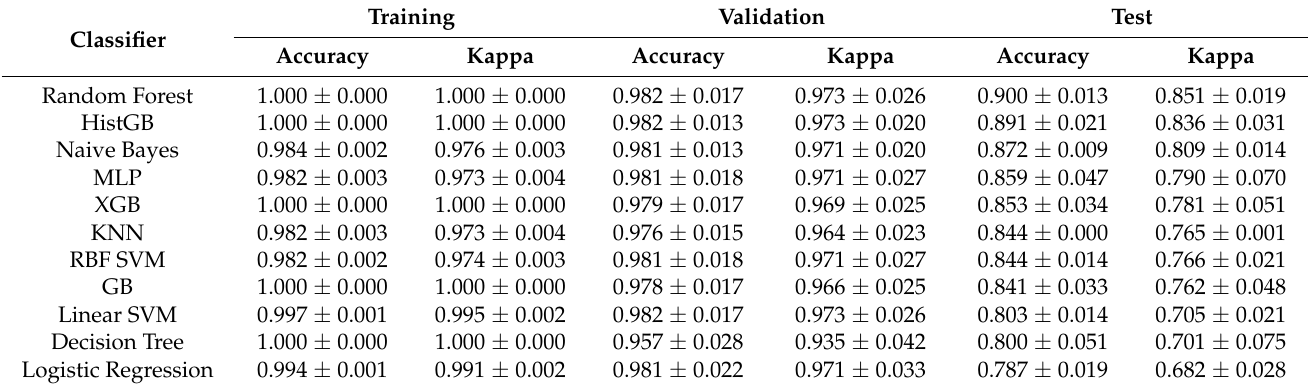
Table 2. Performance evaluation of 11 classifiers based on 512 features of Gerd-VGGNet feature